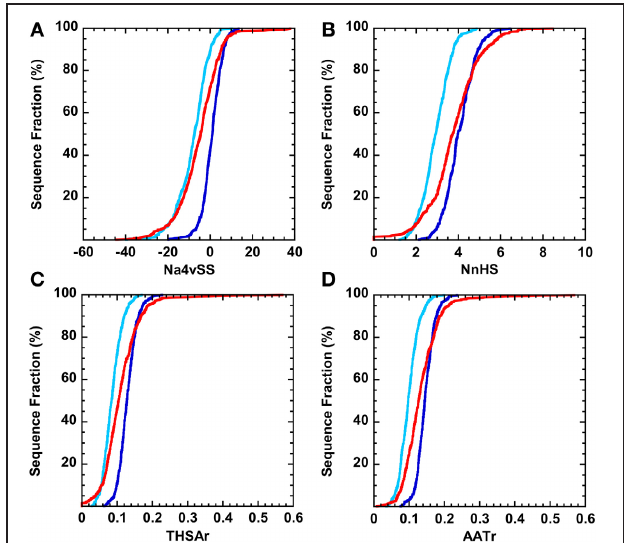
FIGURE 5 | Distribution of aggregation properties over the complete datasets of human kinase proteins (light blue) and domains (dark blue). The red line corresponds to the distribution for a randomized selection of 500 sequences belonging to the Astral40 dataset. (A) Average aggregation propensity (Na4vSS). (B) Normalized number of Hot-spots (NnHS). (C) Total Hot-spot area per residue (THSAr). (D) Area of the aggregation profile above the Hot-Spot Threshold per Residue (AATr).